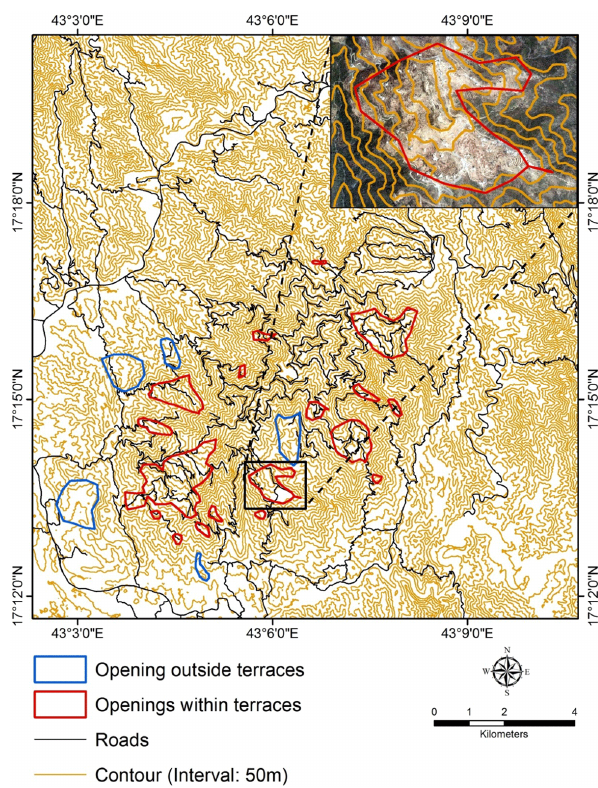
Figure 8. Contoured elevation map showing locations of possible historical landslides; these areas appear as domains of gentle slope surrounded by areas with steep